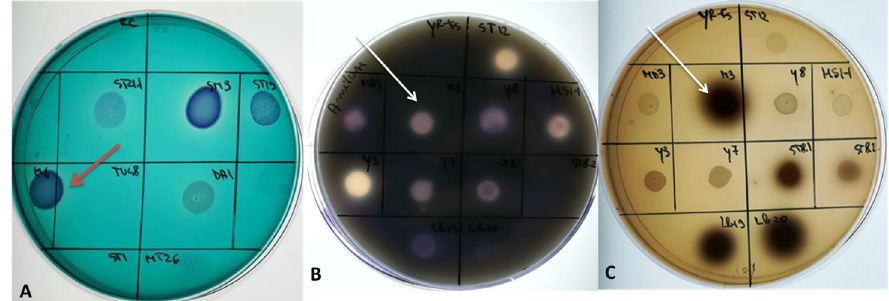
Figure 8. Phenotypic analysis of soluble virulence factors produced by M6 (red arrow) and M3 isolates (white arrow) (( A )—DNases; ( B )—amylolytic enzymes; ( C )—Siderophore-like compounds).